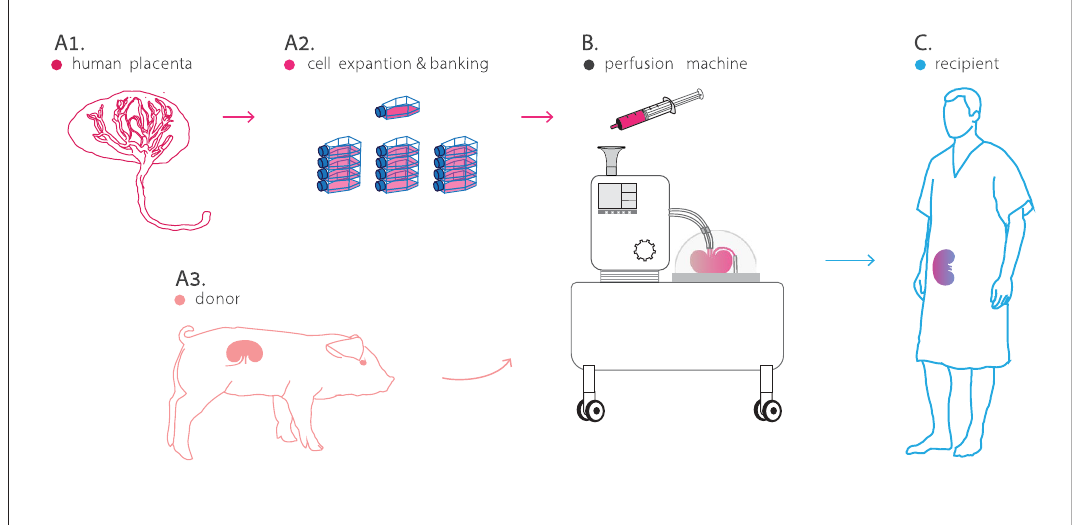
Figure 6. Suggested pathway to immune tolerance. An illustration demonstrating the proposed methodology for generation of transplantable, immunologically-acceptable organs for future translation into clinical practice. Donated human placenta ( A1 ) are used to isolate, expand and bank ABO- and HLA-screened, immunologically-acceptable cells ( A2 ). Pig organs ( A3 ) are procured and mounted on a perfusion machine ( B ) used to rebuild the organ’s vasculature using ABO- and HLA-compatible placental cells. The immunologically- acceptable organ is transplanted into a recipient ( C ). (Illustration by Noa First